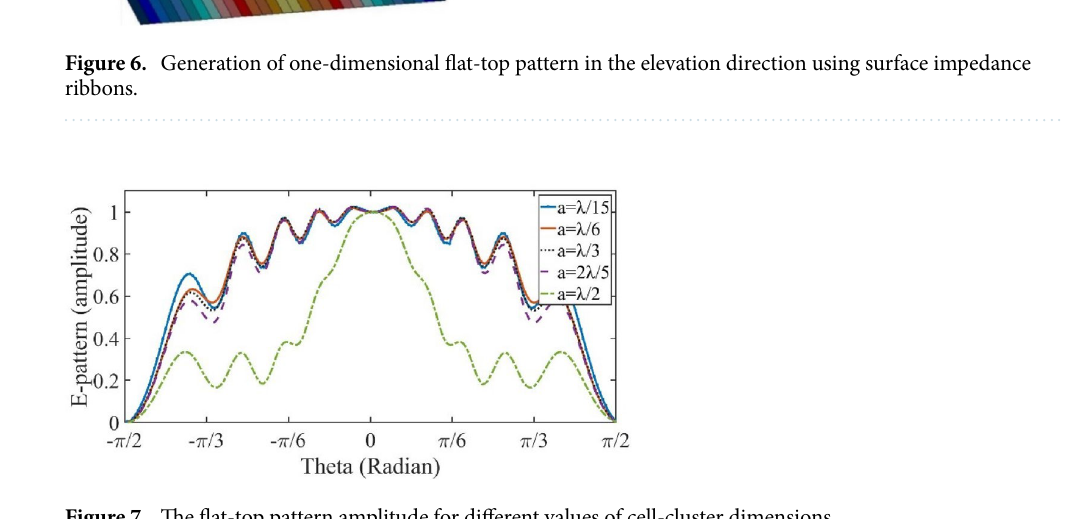
Figure 7. The flat-top pattern amplitude for different values of cell-cluster